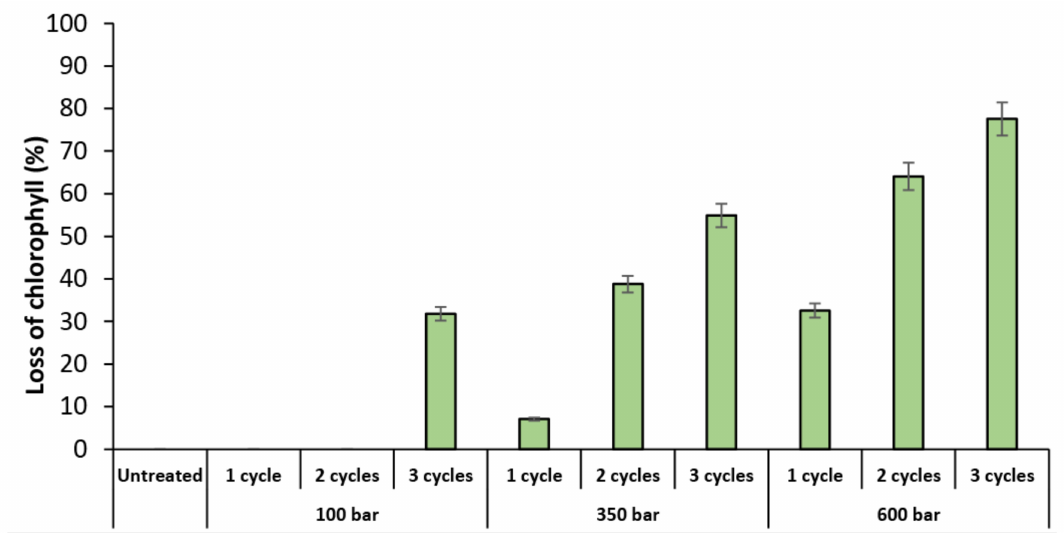
Figure 3. Percentage of Tetradesmus obliquus chlorophyll lost as a result of high-pressure homogenization at different pressure or cycles, determined by flow cytometry. Data are shown as mean ± standard deviation ( n = 2).